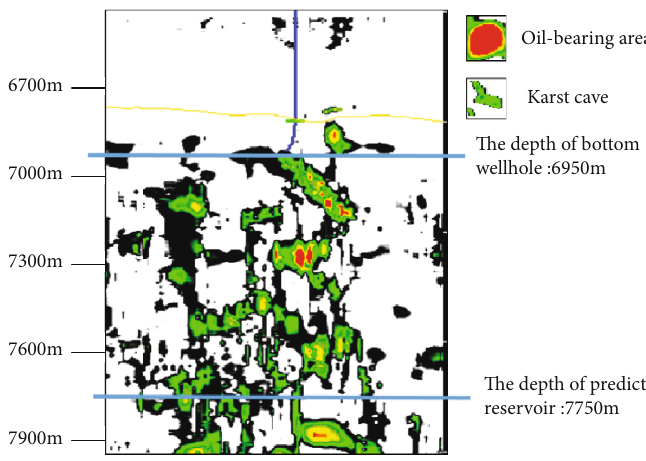
Figure 13: Reservoir prediction depth and seismic pro fi le of